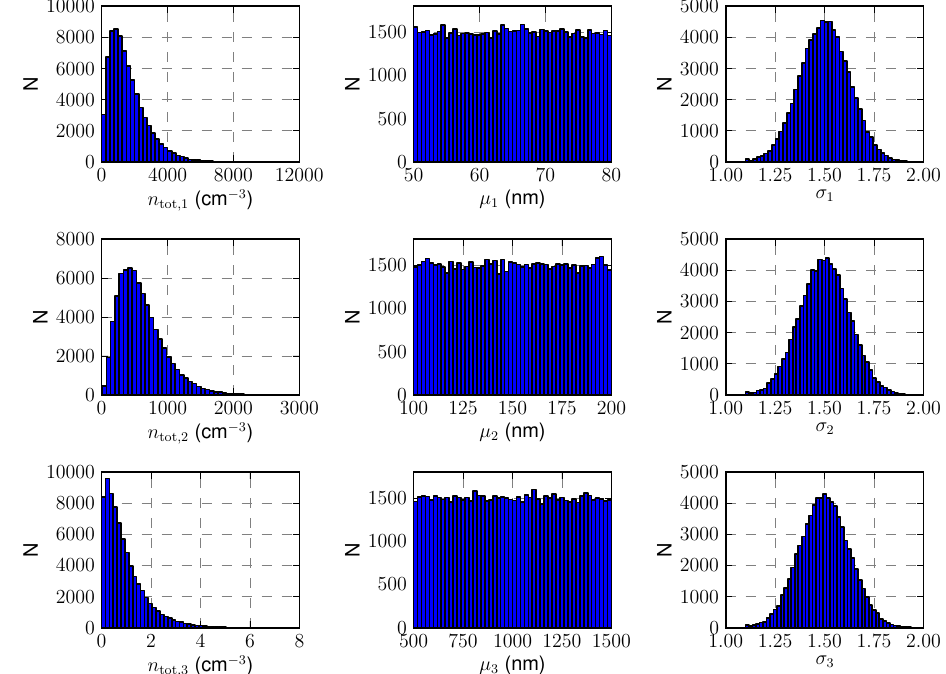
Fig. 4. Histograms for number concentrations of particles n i , scale parameters µ i and shape parameters σ i for the log-normal modes i = 1 , 2 , 3. N denotes the number of samples.